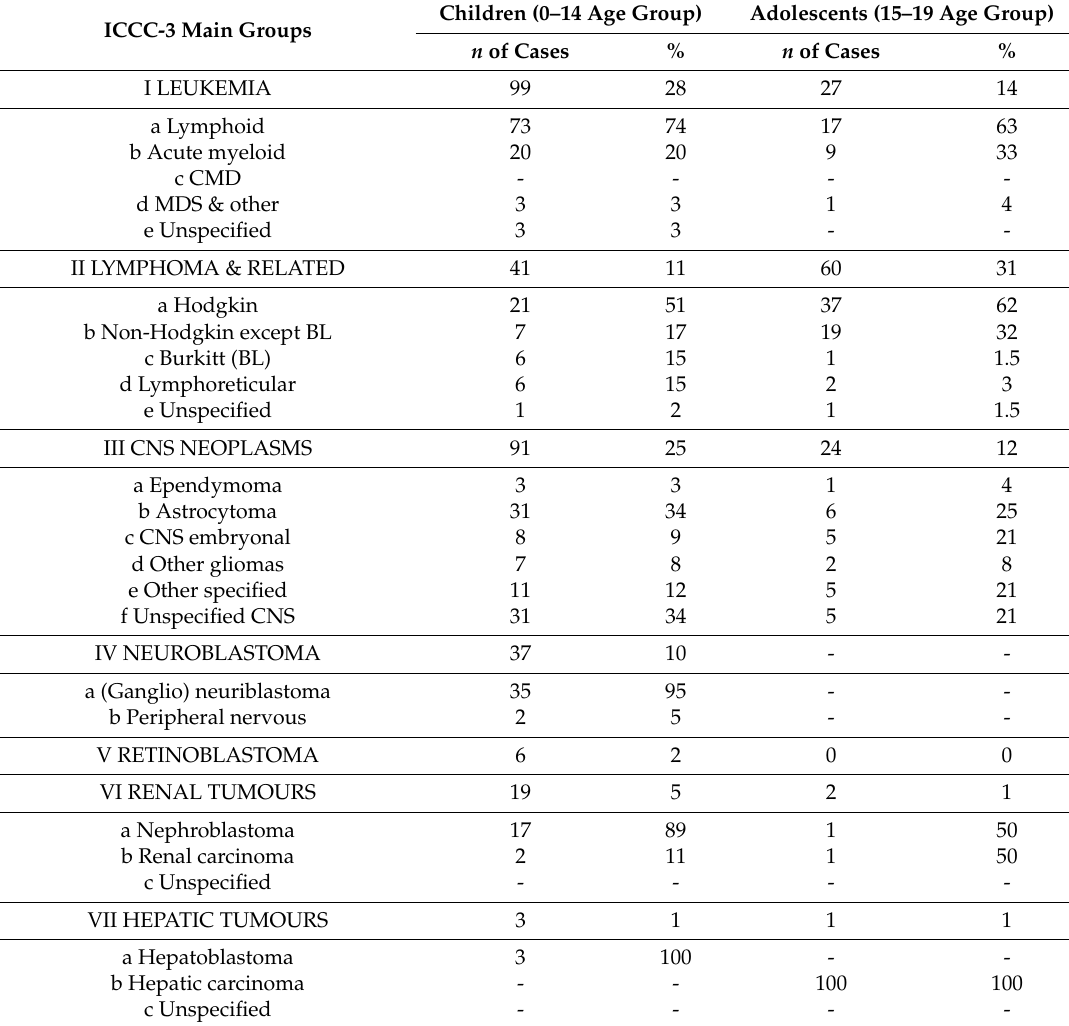
Table 2. Childhood and adolescence tumours incident cases ( n 555) by third revision of International Classification of Childhood Cancer (ICCC-3) groups and age-group. Palermo Province,